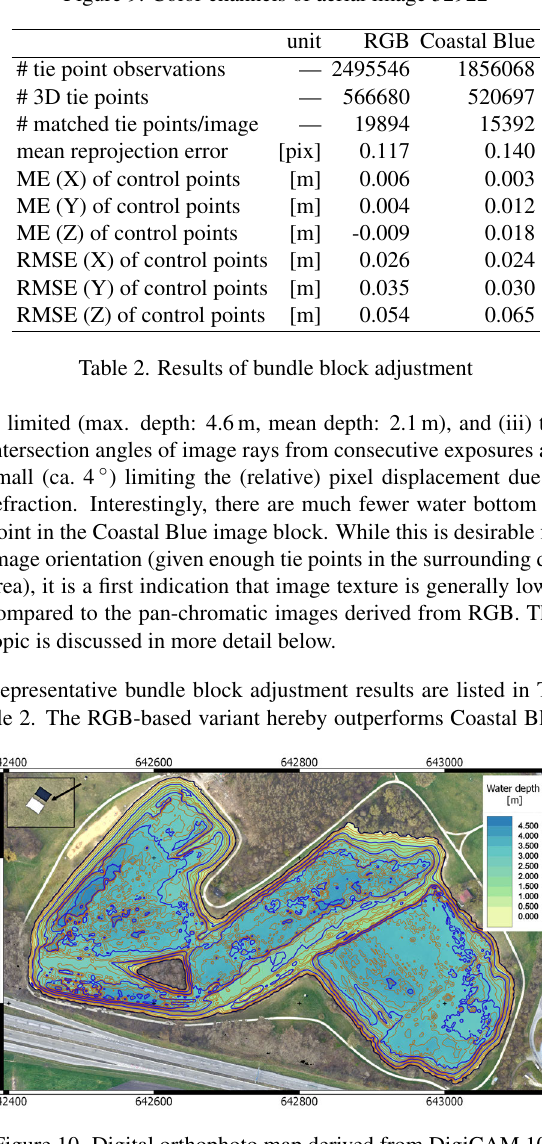
RGB images superimposed with LiDAR derived water depth map (color coded) and depth contours (thin brown lines: 25cm contours, thick blue lines: 1m contours). Detail in upper left corner: radiometric control